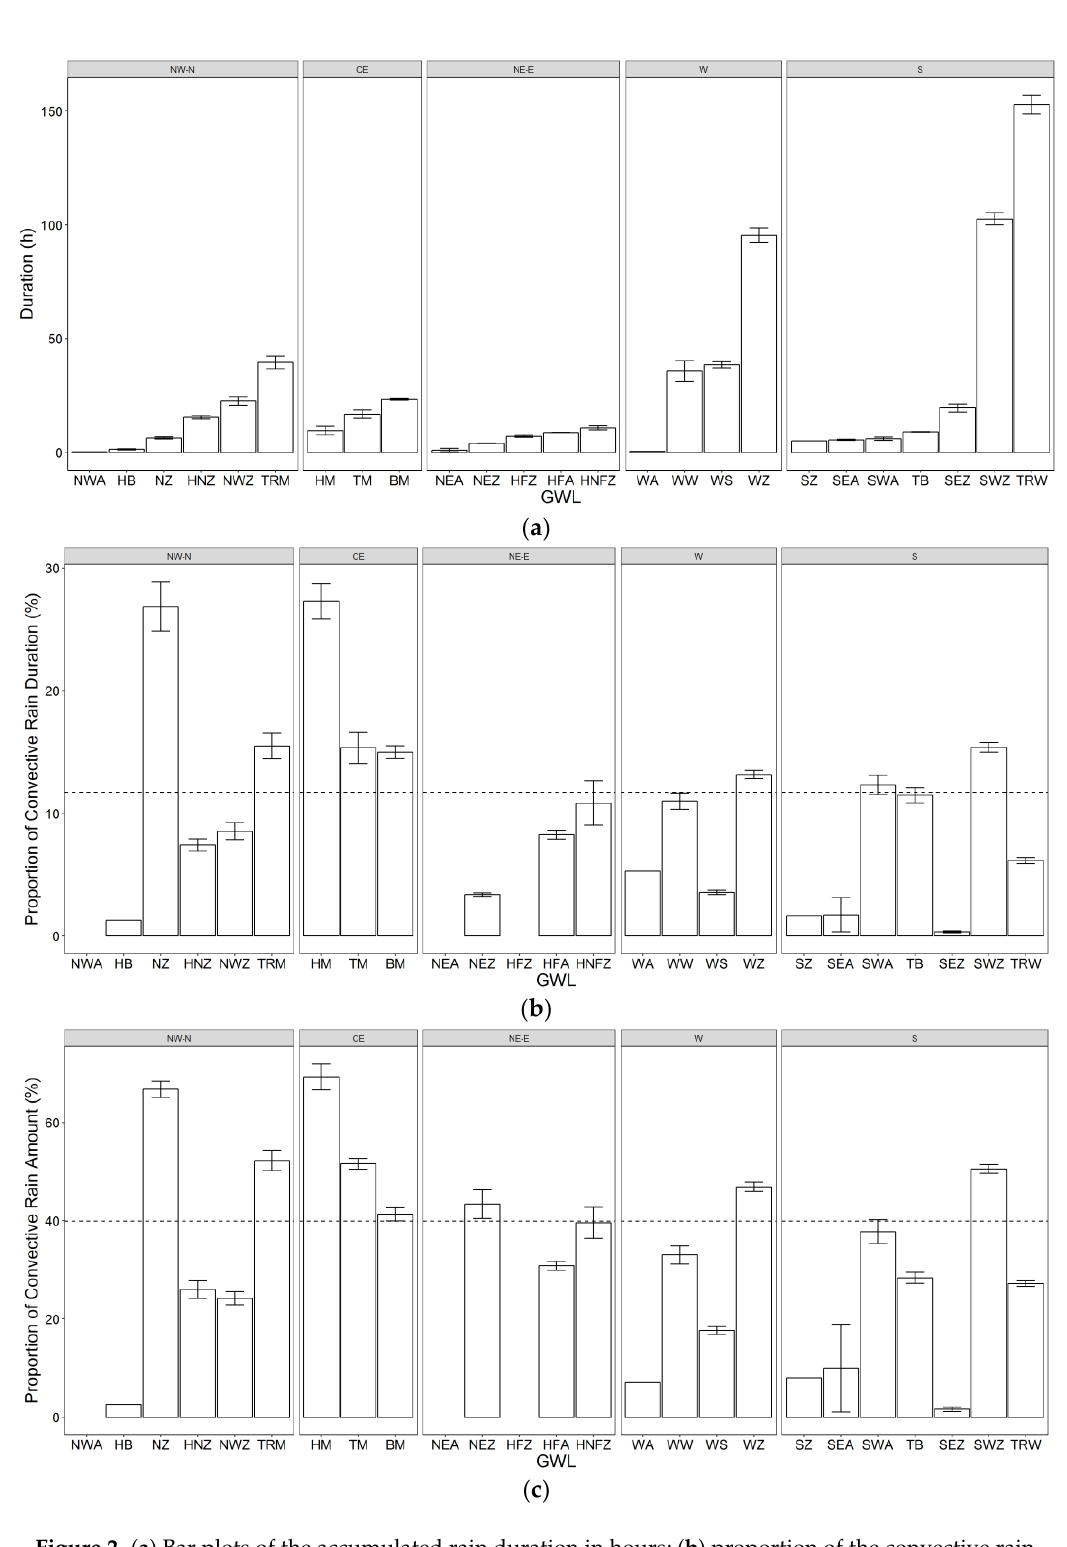
Figure 2. ( a ) Bar plots of the accumulated rain duration in hours; ( b ) proportion of the convective rain duration averaged over the 16 devices for each GWL (see Table 1); and ( c ) proportion of the convective rain amount averaged over the 16 devices for each GWL. Error bars are based on the standard error across devices. GWLs are grouped by flow direction and within each flow direction ordered by accumulated rain duration over all disdrometers. Dashed lines represent the overall proportion of the convective rain duration in panel ( b ) and the convective rain amount in panel ( c ).